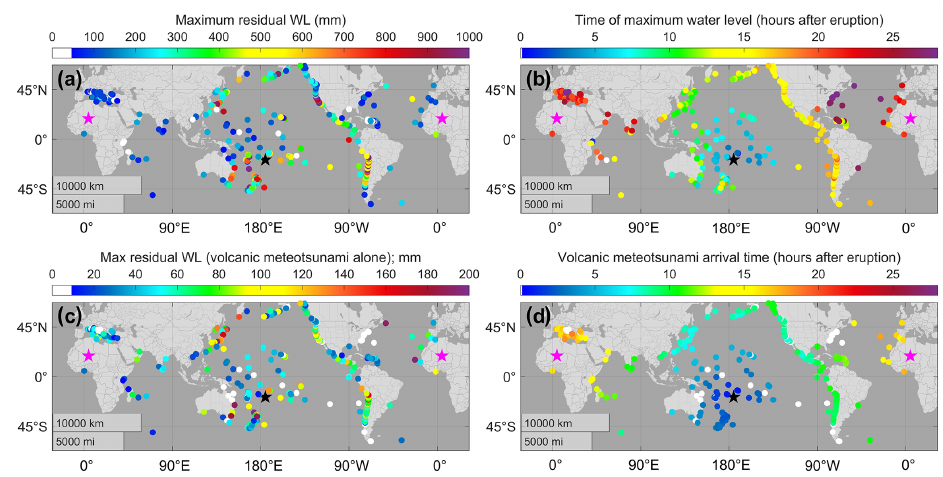
Figure 1. Tonga tsunami global manifestations: (a) maximum amplitude of combined volcanic (VMT) and marine tsunamis, (b) time of maximum amplitude, (c) first arrival VMT amplitude, and (d) VMT arrival time. White markers in (c) and (d) indicate locations where meteotsunami properties could not be determined. The locations of the eruption and its antipode are shown by black and magenta stars, respectively. Maps made in MATLAB using data from Natural